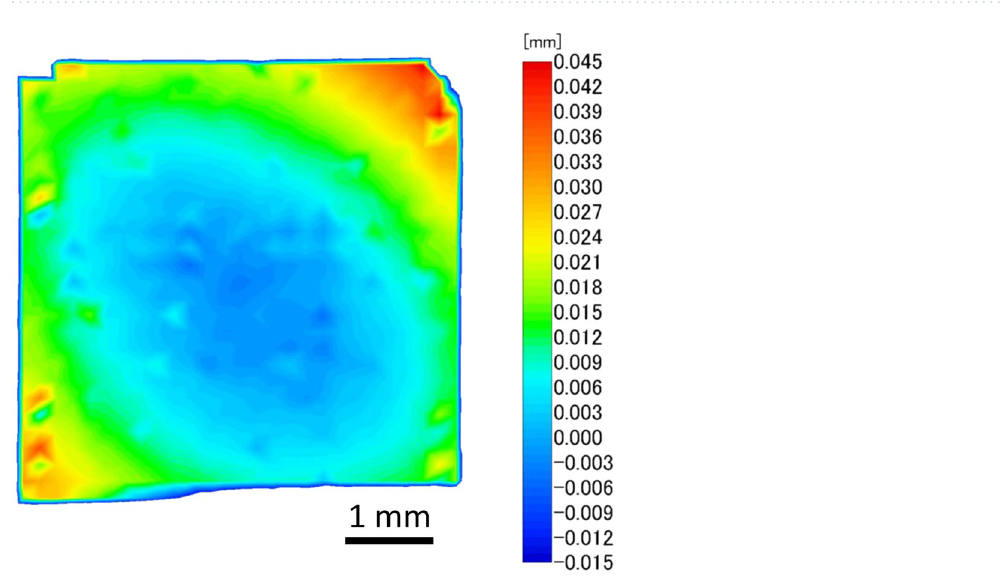
Figure 4. Height distribution of HEMT sample